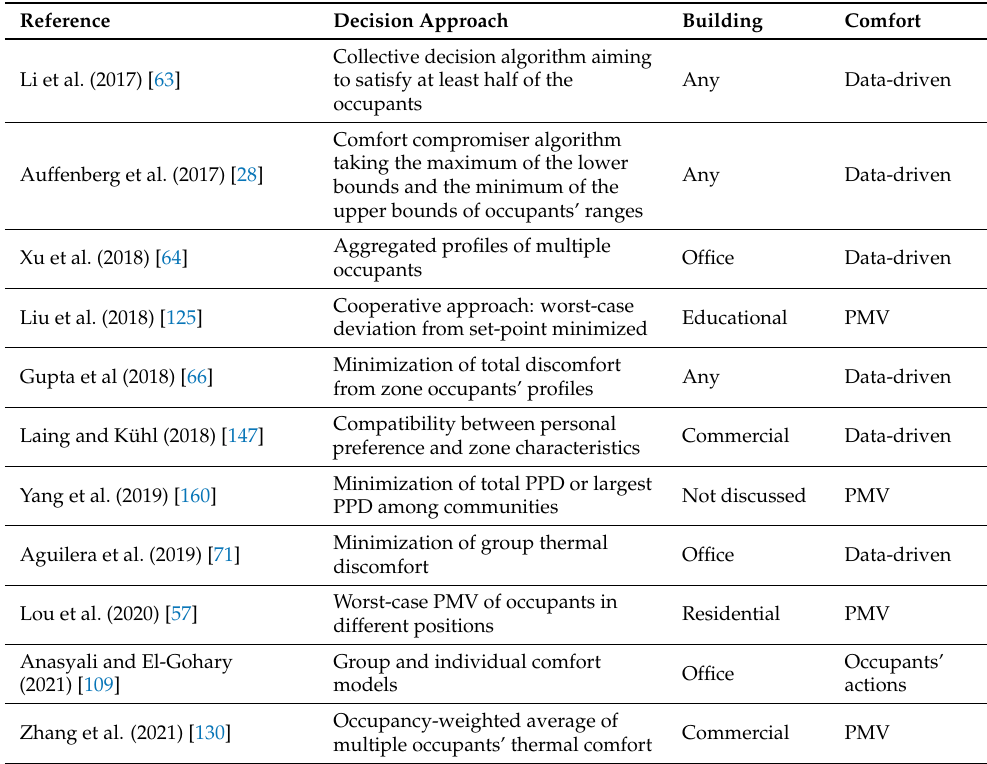
Table 10. Decision approach to synthesize individual preference into group settings (multi-